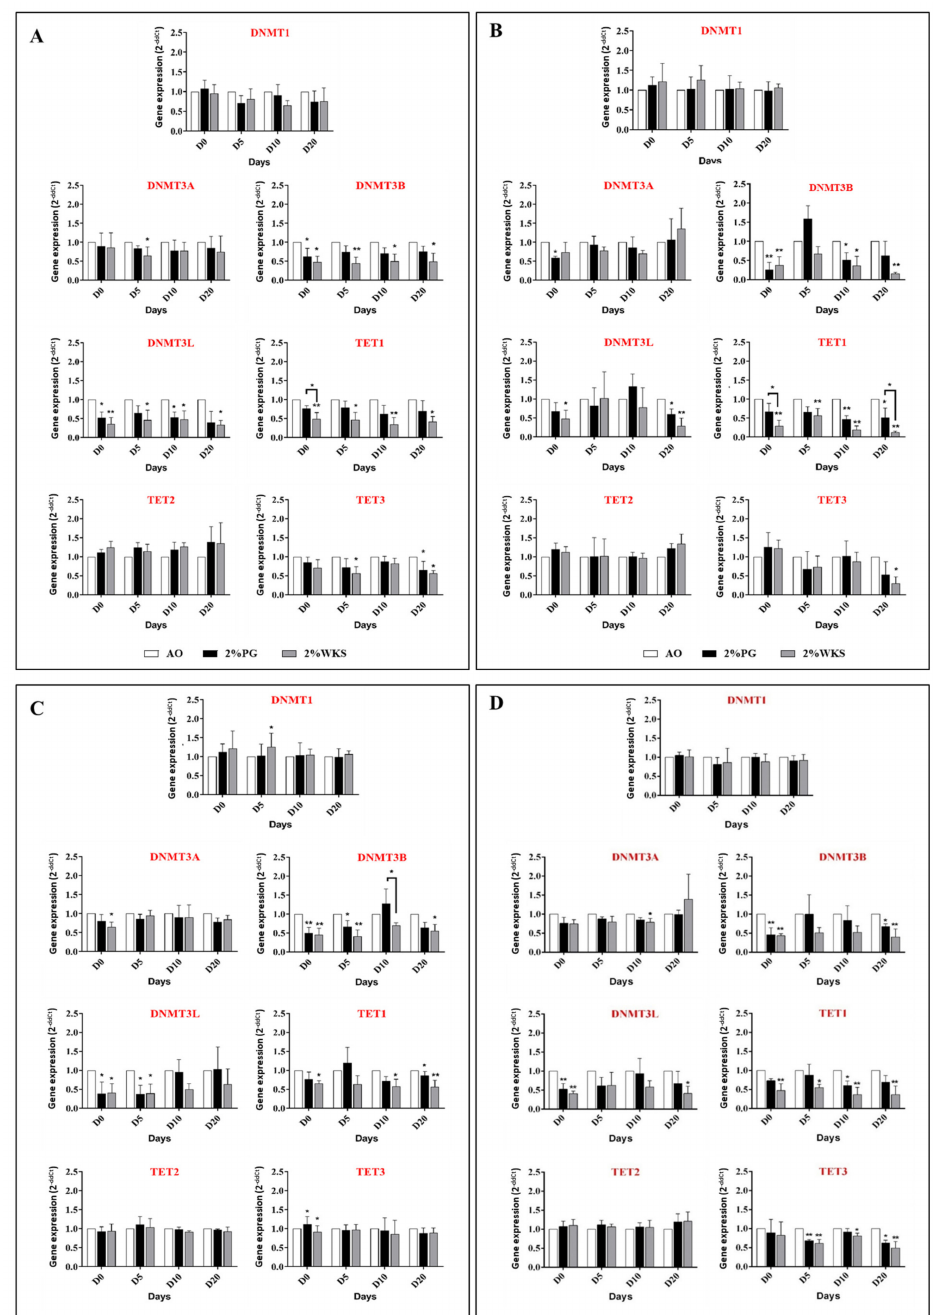
Figure 5. QRT-PCR analysis of DNMTs and TETs in PSCs. Gene expression of DNMTs and TETs was performed ( A ) SHEF1, ( B ) SHEF2, ( C ) ZK2012L, and ( D ) Pooled PSCs lines, (SHEF1, SHEF2 and ZK2012L) in 21% AO and physiological oxygen conditions (2% PG and 2% WKS). The internal control ACTB was used for normalization. Y -axis shows the relative changes in 2 − ∆∆ CT of air oxygen to physoxia. The X -axis indicates time (days). Data are presented as a mean ( n = 3), * p < 0.05, ** p < 0.01 vs. 21% AO, connecting lines indicate significance between conditions, error bars indicate SD. DNMT3L expression significantly decreased in undifferentiated and 10-days differen- tiated SHEF1 in 2% PG ( p < 0.05) and 2% WKS ( p < 0.01 and p < 0.05, respectively), and in 2%WKS at days 5 and 20 ( p < 0.05) in comparison to 21% AO (Figure 5A). A decreased expression of DNMT3L was noted in undifferentiated 2% WKS ( p < 0.05) and 20-days